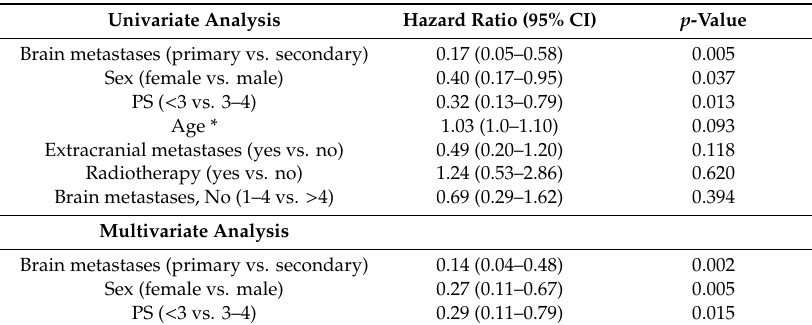
Table 3. Univariate and multivariate Cox regression analysis for